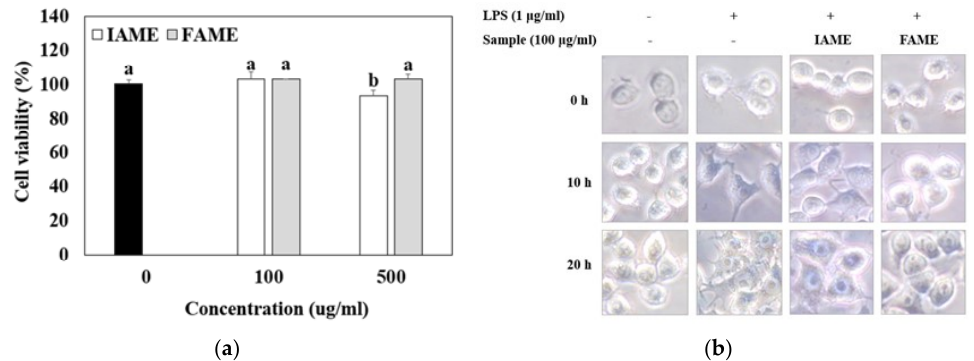
Figure 4. Effects of IAME and FAME on ( a ) cytotoxicity and ( b ) morphological changes in Raw264.7 cells. ( a ) Raw264.7 cells were incubated with IAME and FAME for 20 h. The cell viability of Raw264.7 cells was assessed by performing an MTT assay. ( b ) Raw264.7 cells were pretreated with IAME and FAME for 2 h and then stimulated with lipopolysaccharide (LPS) for 10 or 20 h on cover slides. Morphological changes in Raw264.7 were visualized via optical microscopy ( × 400). IAME, Abelmoschus manihot extract; A. manihot extract fermented by Bacillus licheniformis